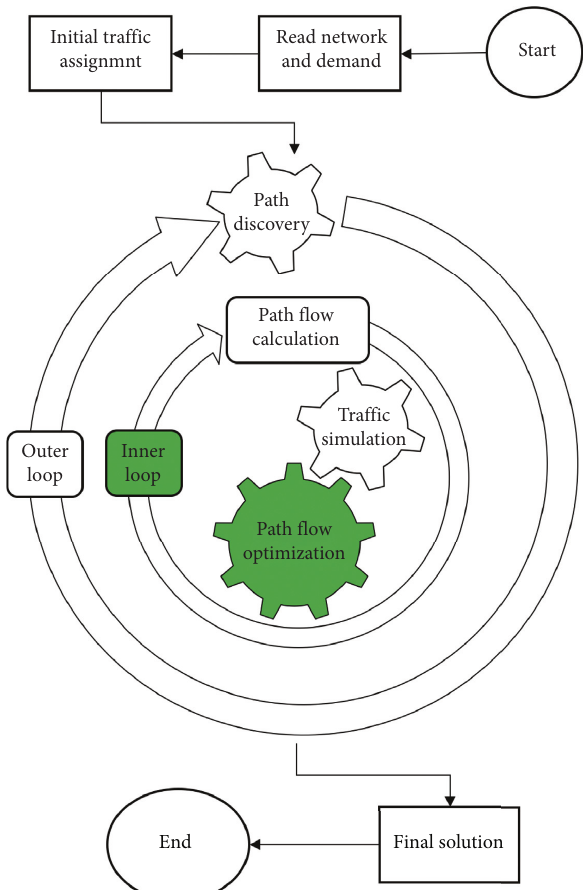
Figure 1: Simulation-based DTA process: column generation